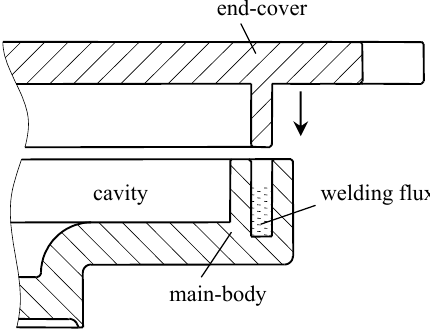
Figure 2. The schematic to the sealing of main-body and end-cover.